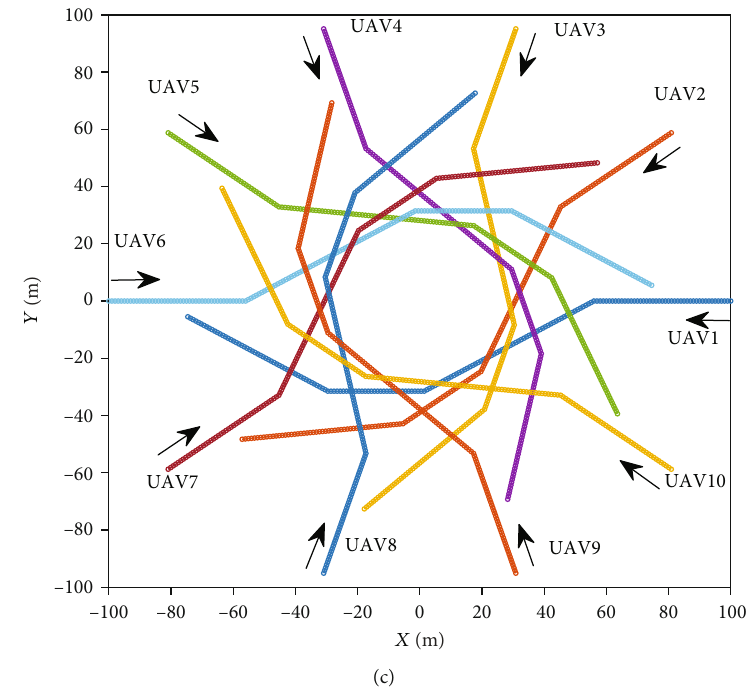
Figure 9: Con fl ict resolution strategies based on APF-GA: (a) 2 UAVs ’ con fl ict, (b) 6 UAVs ’ con fl ict, and (c) 10 UAVs con fl